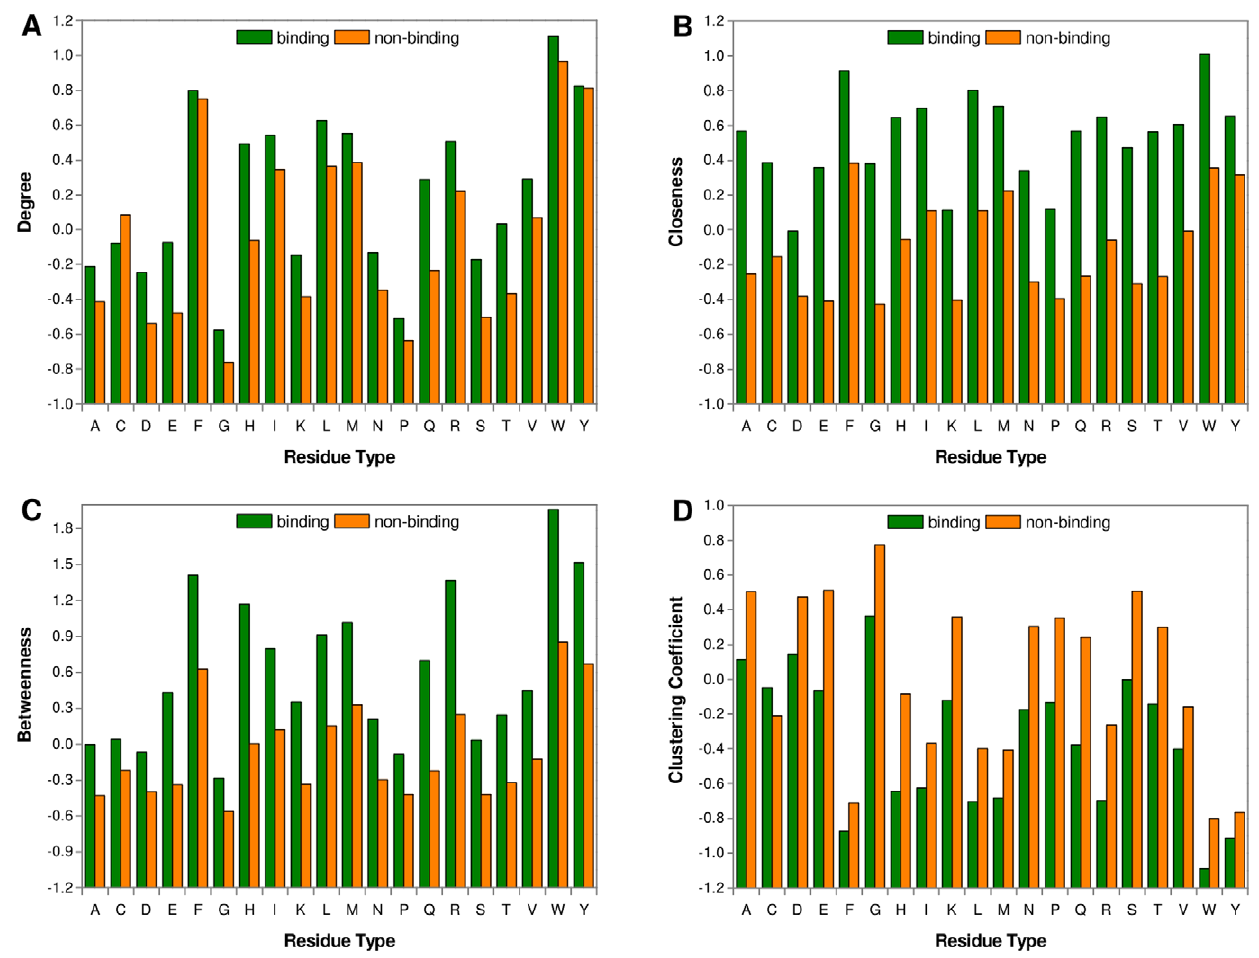
Figure 2. Comparison of network-based features of heme-binding and non-binding residues based on residue type. (a) Degree; (b) Closeness; (c) Betweenness; (d) Clustering Coefficient. For each topological feature, we compared the means of the z-scores of binding and non- binding residues in Dataset 1 for different residue types.